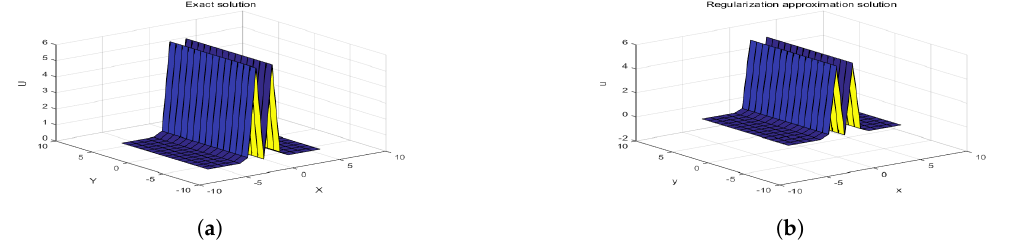
Figure 3. Example 1: For δ = 2 × 10 − 8 , z = 1: ( a ) Exact solution, and ( b ) approximation solution.